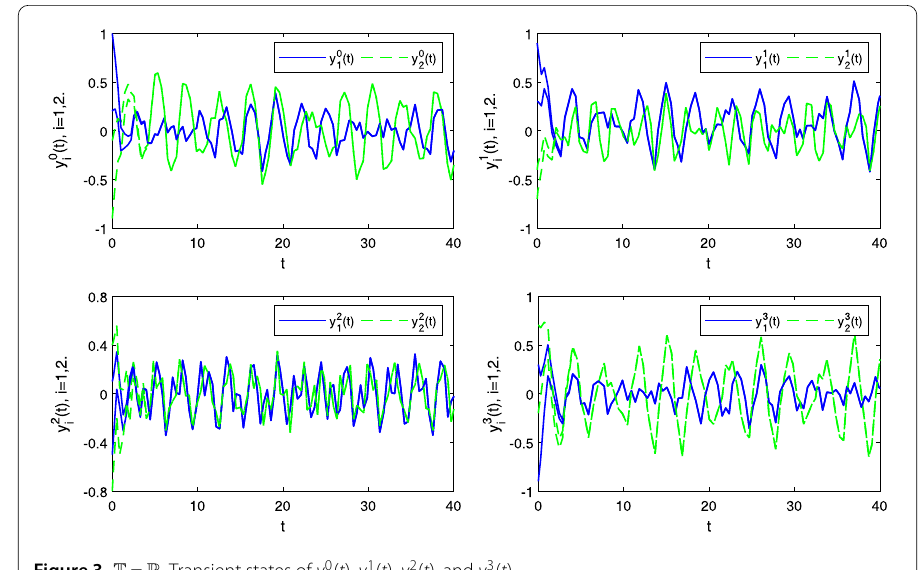
Figure 3 T = R . Transient states of y 0 ( t ), y 1 ( t ), y 2 ( t ), and y 3 ( t )